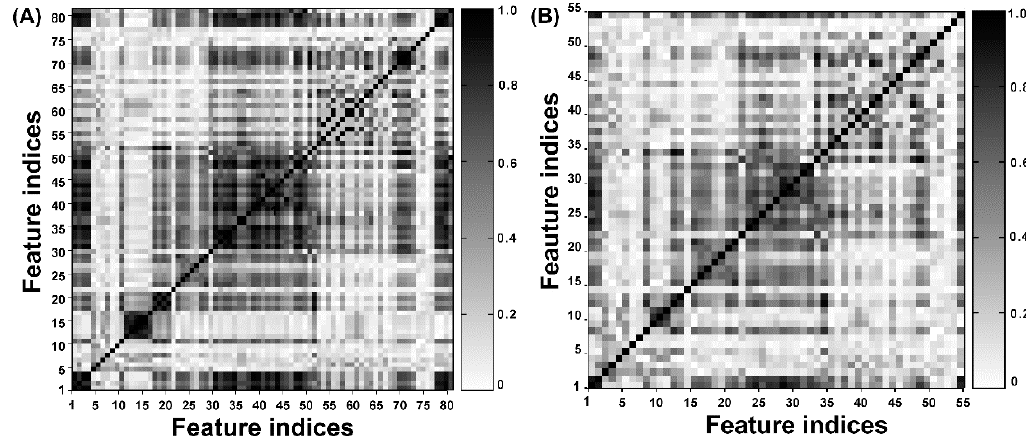
Figure 5. ( A , B ) Represents the contour graphs of the intercorrelation matrix of molecular descriptors before and after feature selection, respectively.